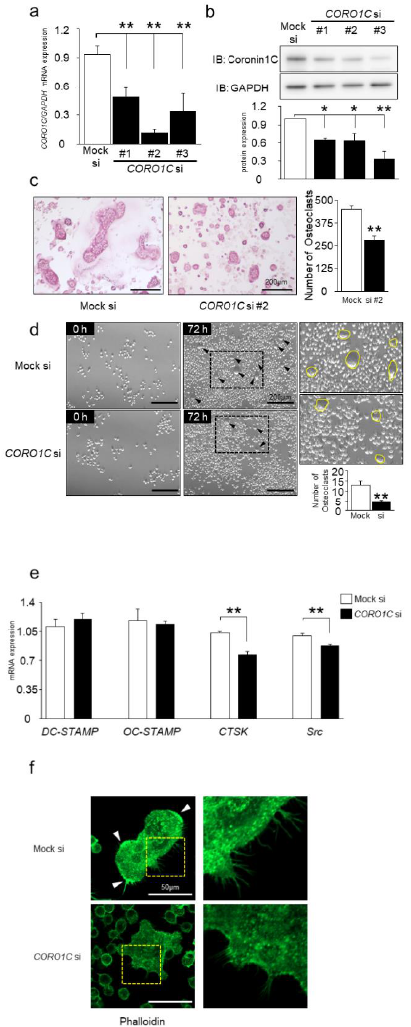
Figure 4. Effects of Coronin1C knockdown on osteoclast differentiation. ( a ) For knockdown efficiency, RAW-D cells were transfected with 3 types of CORO1C siRNA (Coronin1C si), followed by stimulation with RANKL (100 ng/mL) for 3 days. The Coronin1C mRNA levels were analyzed by qPCR. ** p < 0.01; compared with the mock cells. ( b ) The Coronin1C protein levels of 3 types were analyzed by Western blot. Quantitative analysis of proteins in cell lysates by relative chemiluminescence intensity measured with ImageJ. Measurements were normalized by Mock si. * p < 0.05, ** p < 0.01; compared to Mock si. ( c ) TRAP staining of multinucleated cells derived from Coronin1C si and the Mock si cells treated with RANKL for 4 days. ** p < 0.01; ( d ) Time-lapse images at 0 h and 72 h of Mock si (upper) and CORO1C si cells (lower). The arrowheads point to multinucleated cells. The magnified images on the right are images of the area circled by the dotted line in the 72-h images. Cells bordered in yellow are multinucleated cells. The number of multinucleated cells was counted. ** p < 0.01; compared to mock si cells. ( e ) Comparison of mRNA levels of various osteoclast marker genes in CORO1C si and the Mock si cells. RAW-D cells were cultured with RANKL (100 ng/mL) for 3 days. After mRNA isolation from these cells, RT-PCR was performed. ** p < 0.01, compared with the Mock si cells. ( f ) Phalloidin staining of multinucleated cells derived from Coronin1C si and the Mock si cells treated with RANKL for 3 days. The arrowheads point to lamellipodia in cells. The area enclosed by the yellow dotted line has been enlarged and is shown to the right. The enlarged photos show